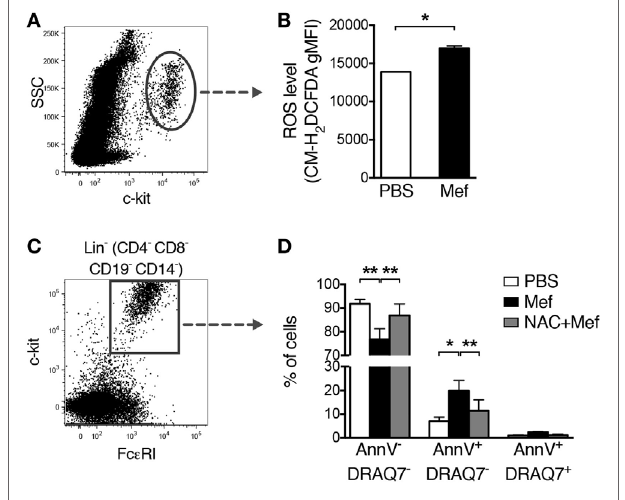
FigUre 4 | Oxidative stress induced by mefloquine is a major cause of mast cell apoptosis. (a,B) Mixed human lung cells were prepared by mechanical and enzymatic treatment of lung specimens and treated with phosphate- buffered saline (PBS) or mefloquine (20 µM) for 1 h. Next, c-kit + cells were gated (a) and the reactive oxygen species (ROS) levels were quantified using the fluorescent ROS probe CM-H 2 DCFDA (B) . The bars in panel (B) represent mean ± SEM of the geometric mean fluorescence intensity (gMFI) for the CM-H 2 DCFDA (* P < 0.05) ( n = 2; representative of two independent experiments/two donors). (c,D) Mixed human lung cells were pre-incubated with or without N-acetylcysteine (NAC) (8 mmol/L) for 2 h, followed by treatment with mefloquine (20 µM) or PBS for 24 h. Lin − c-kit + Fc ε RI + mast cells were gated (c) and the percentage of viable (Annexin V − /DRAQ7 −